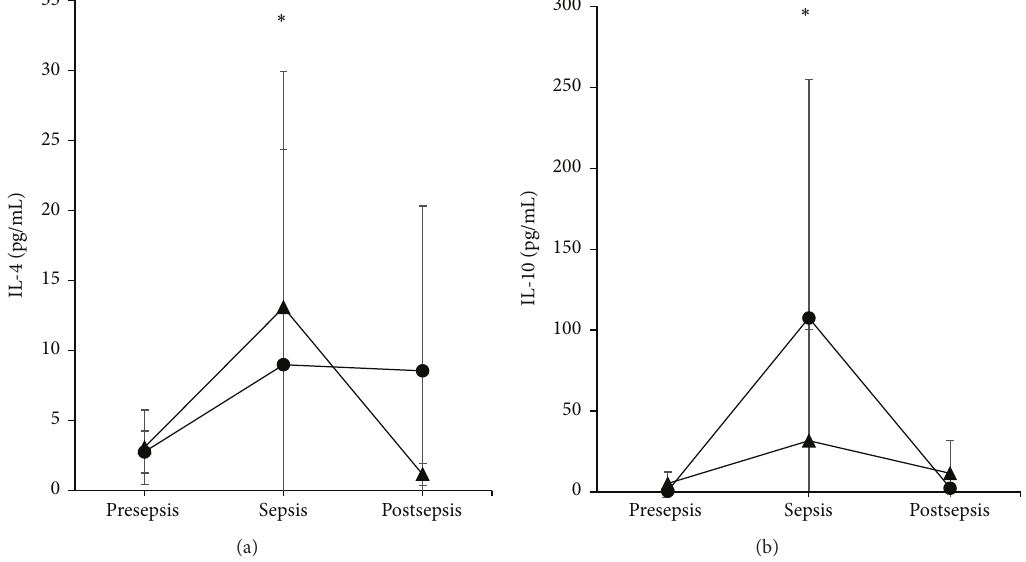
Figure 4: Anti-inflammatory cytokines. IL-4 (a) and IL-10 (b) increased in both the PT (circle) and VPT (triangle) groups during sepsis (mean ± standard deviation), compared to pre- and postsepsis. Only PT group was statistically different ( ∗ 𝑃 < 0.01 , Friedman test). At sepsis time no differences were found between PT and VPT